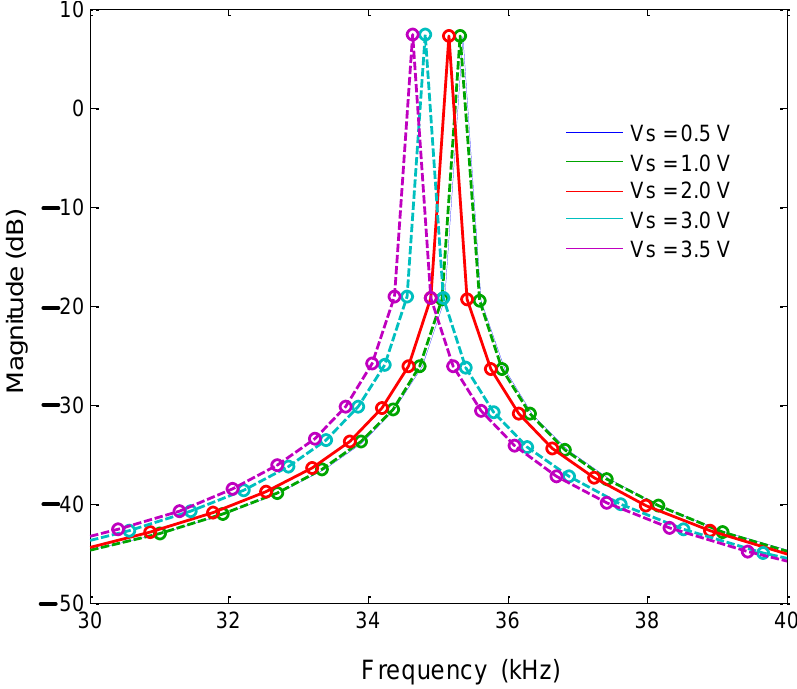
Figure 18. Amplitude frequency curve (single-stage beam). The self-made rotary slide and dial could achieve a precise adjustment of 0.5°, providing acceleration input from − 1 g to 1 g through gravity decomposition. The test instrument is shown in Figure 19, and the corresponding voltage supply mode remained unchanged.